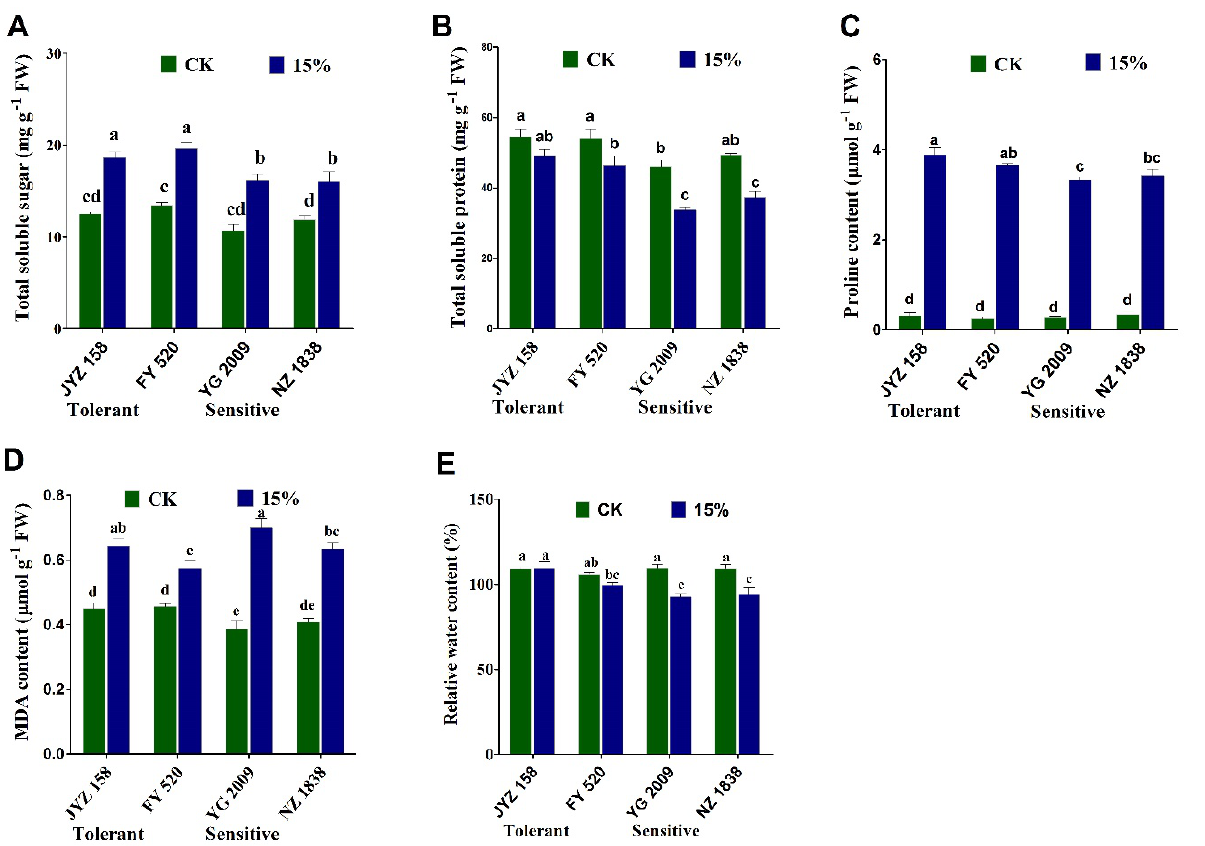
Figure 6. Effects of drought stress (PEG-6000-induced) on ( A ) total soluble sugar (TSS), ( B ) total soluble protein (TSP), ( C ) proline content, ( D ) MDA content and ( E ) water content in four rapeseed cultivars during the early seedling stage. Bars represent mean ± SE of three replicates. Different letters indicate significant differences at p < 0.05 using Duncan’s multiple range tests.